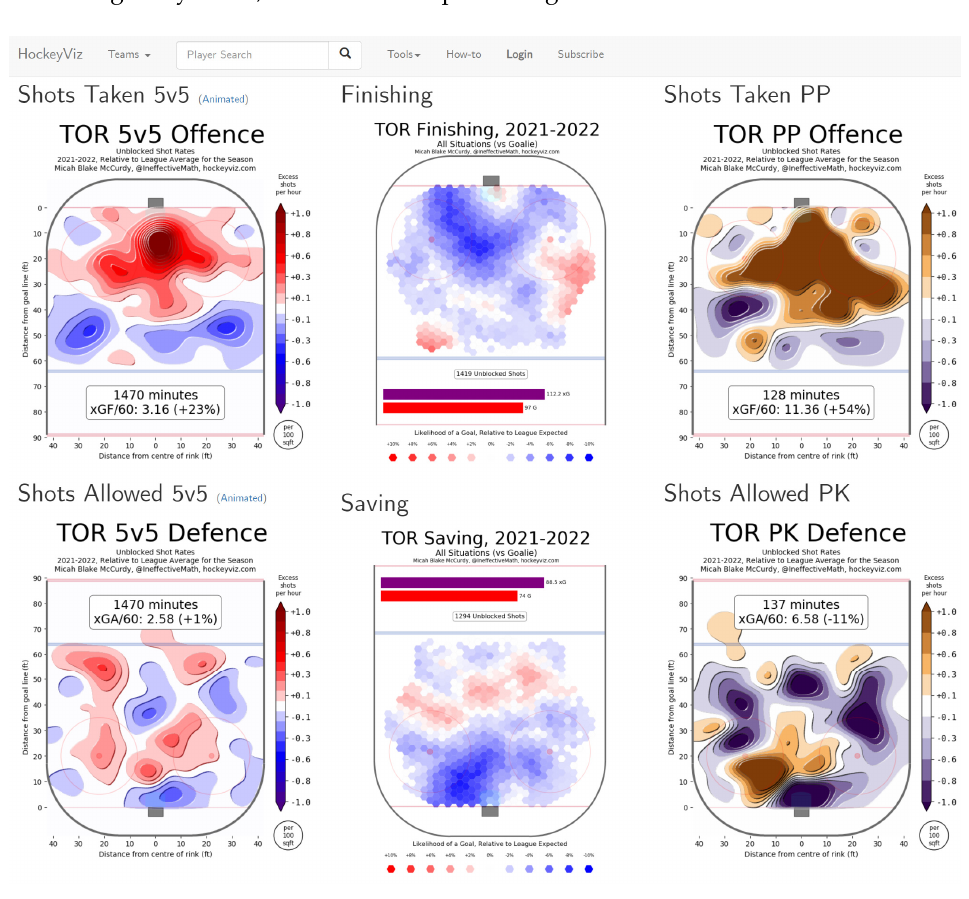
Figure 4. HockeyViz Team Assessments. Source: image generated on 21 December 2021using the public web portal provided by HockeyViz, https://hockeyviz.com/team/TOR/2122 (accessed on 21 December